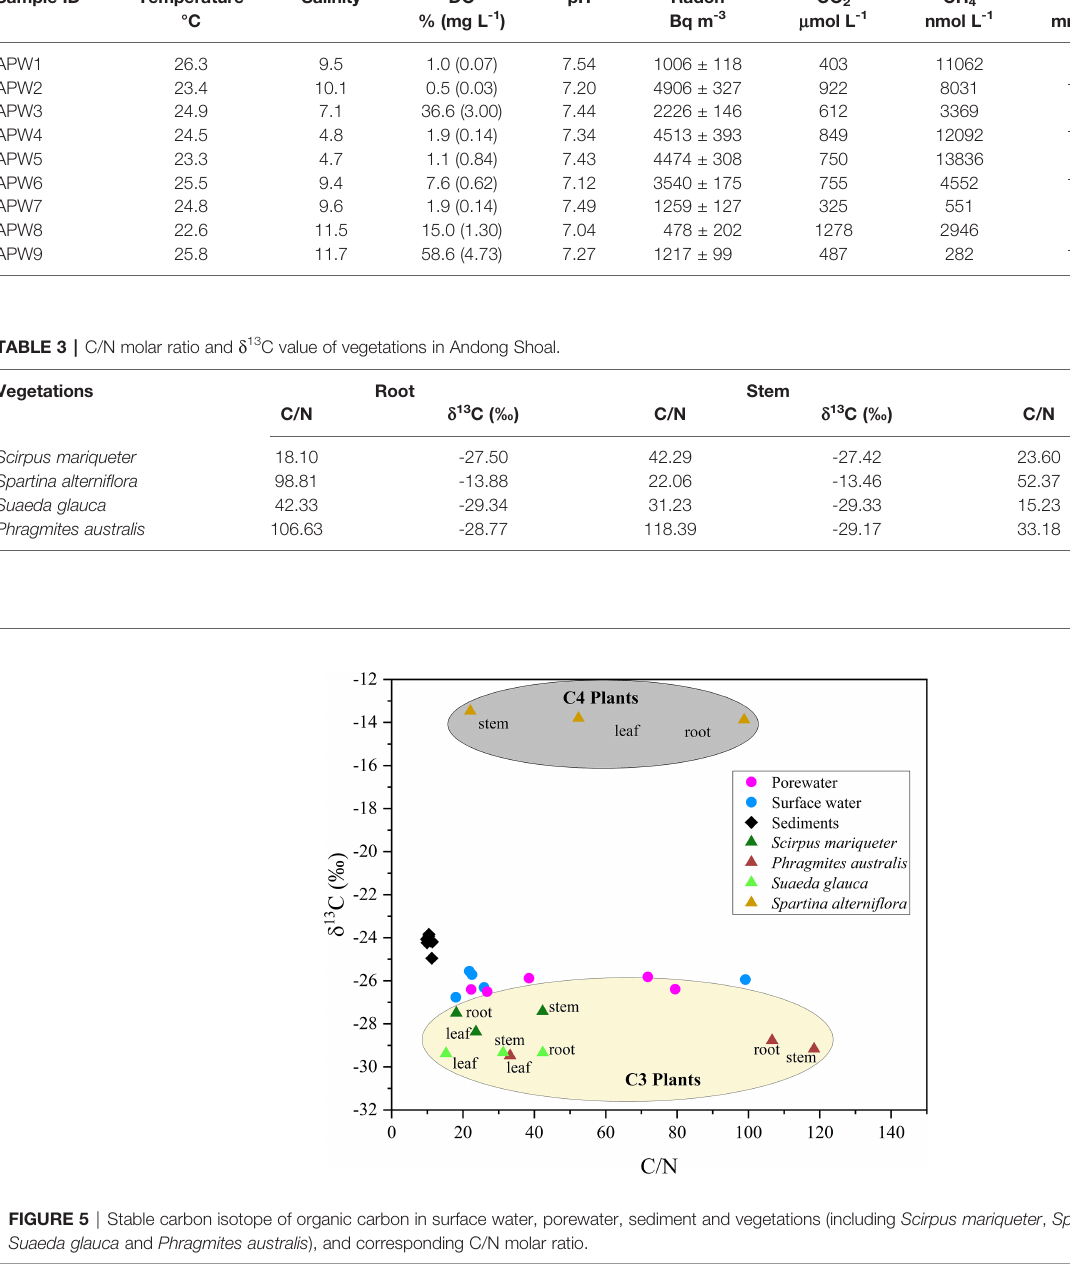
TABLE 2 | Summary of porewater observations. Sample ID Temperature